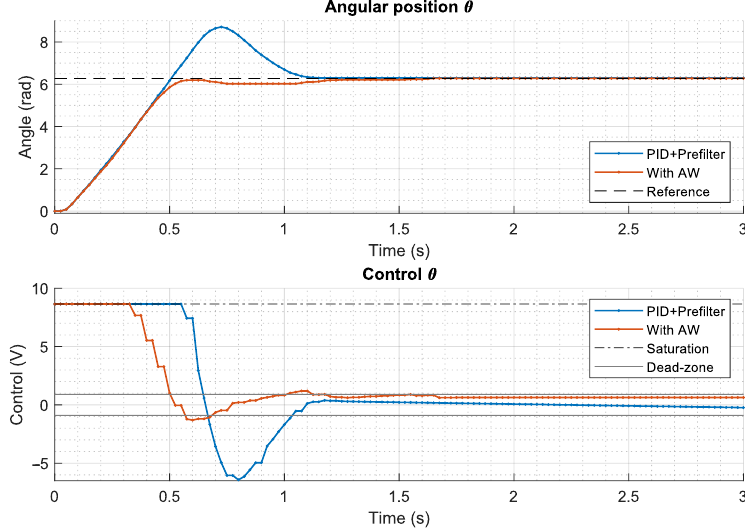
Figure 17. Back-right wheel experimental results with and without